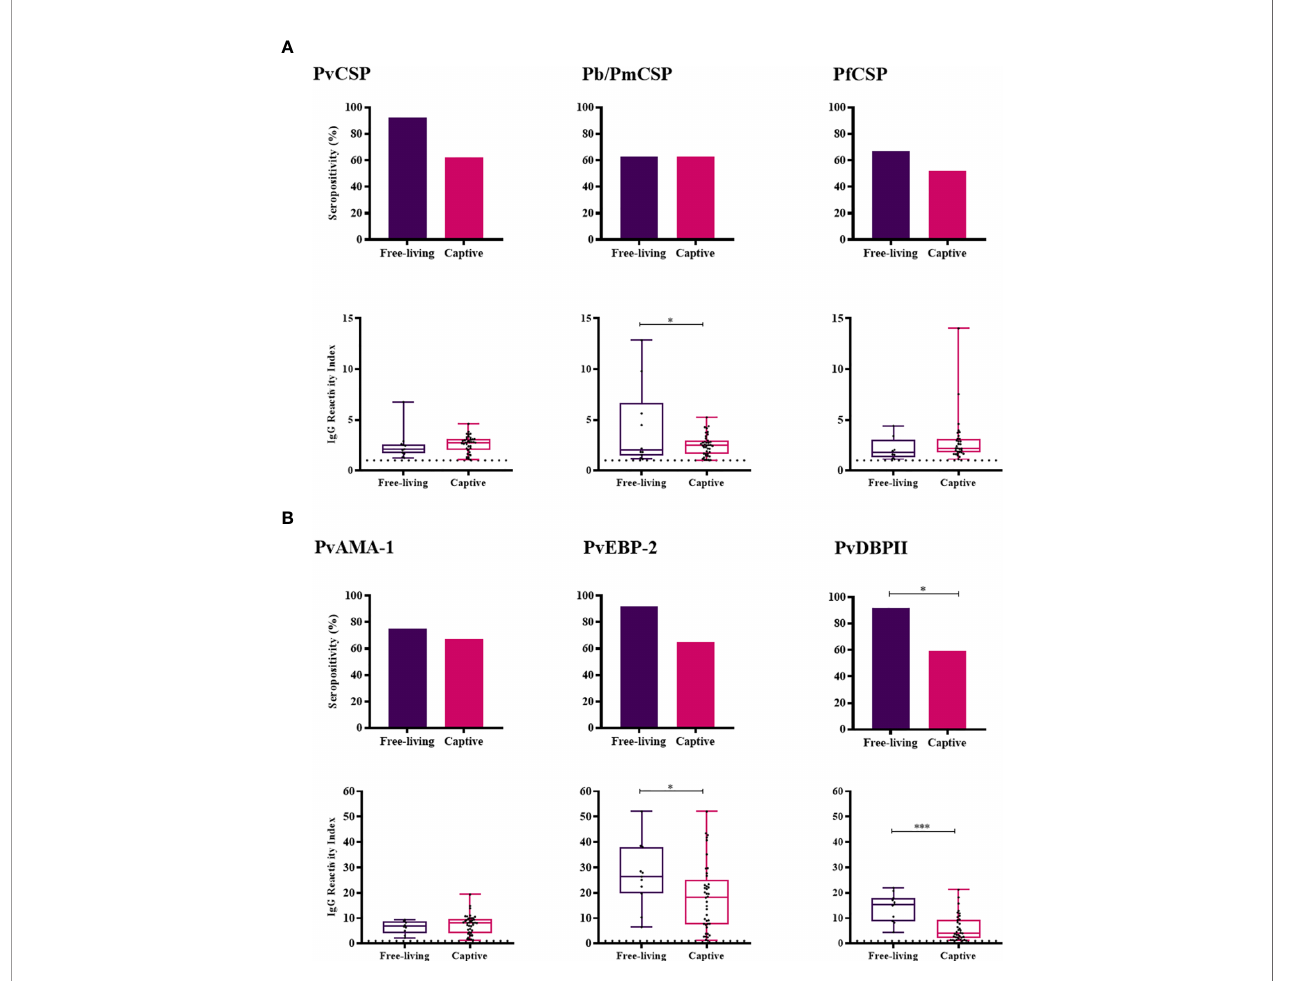
FIGURE 3 | Prevalence and levels of antibodies against Plasmodium antigens in Free-living and Captive animals from Indaial/SC. Seropositivity and reactivity index (RI) of IgG antibodies against (A) CSP peptides and (B) Plasmodium vivax erythrocytic antigens. RI > 1 was considered positive (dotted line). The fi lled bars indicate the percentage of NP with RI > 1 ( A , B top). Data expressed as individual RI values (dots) and median with the interquartile range (boxes) ( A , B botton). PvCSP: CSP repeats representing P. vivax CSP variants (VK210, VK247, and P. vivax-like ); Pb/PmCSP: CSP repeat of P. brasilianum/P. malariae ; PfCSP: CSP repeat of P. falciparum ; PvAMA-1: P. vivax Apical membrane antigen – 1; PvEBP-2: P. vivax Erythrocyte Binding Protein 2; PvDBPII: P. vivax Duffy Binding Protein region II. Free-living: purple; Captive: pink. Differences statistically signi fi cant were indicated by asterisk (* P < 0.05; *** P <